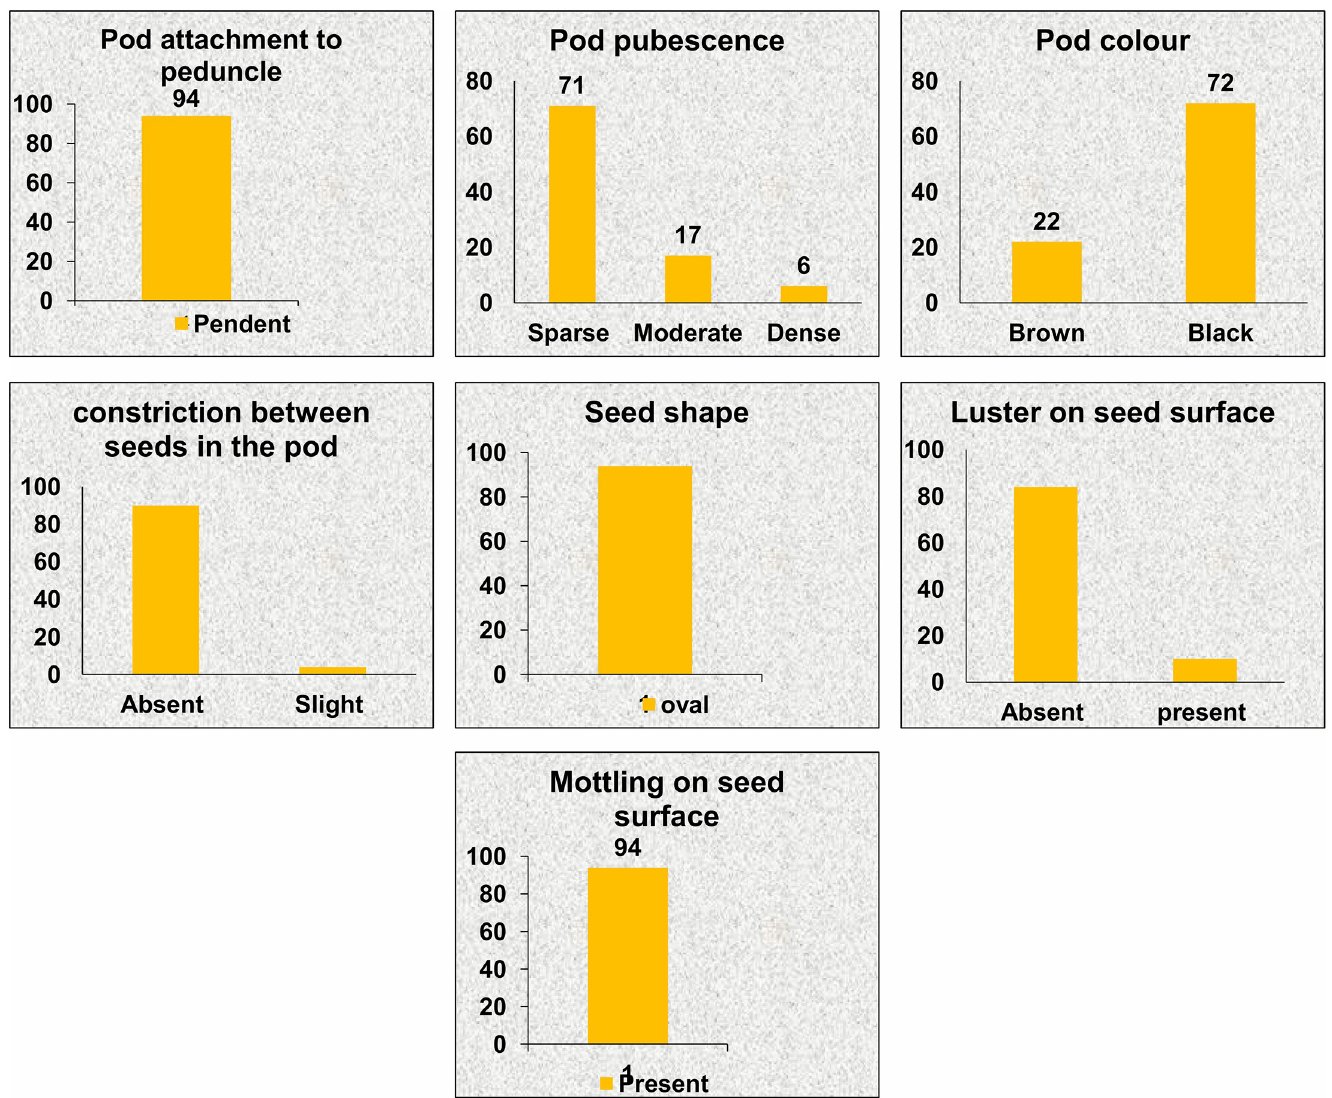
Fig 5. Variation in qualitative traits at pod formation and maturity stage among 94 accessions of V . stipulacea .